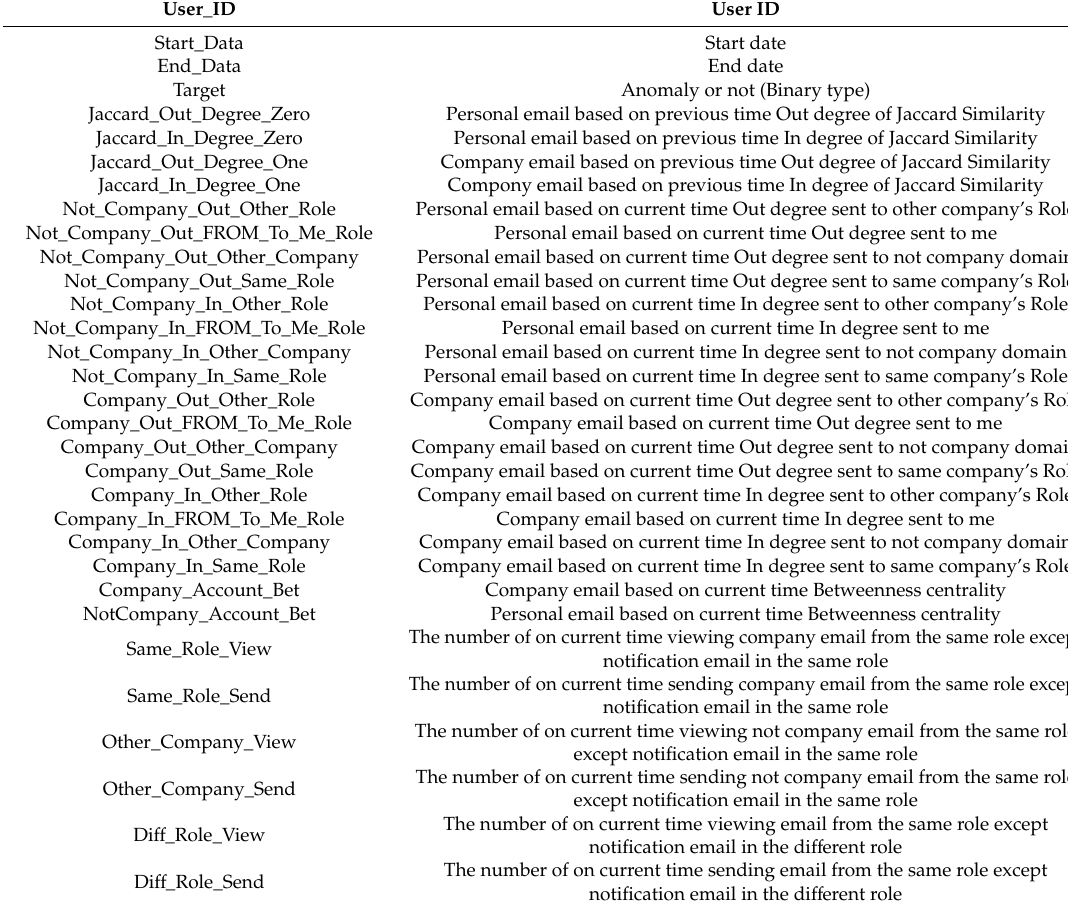
Table A3. List of email networks